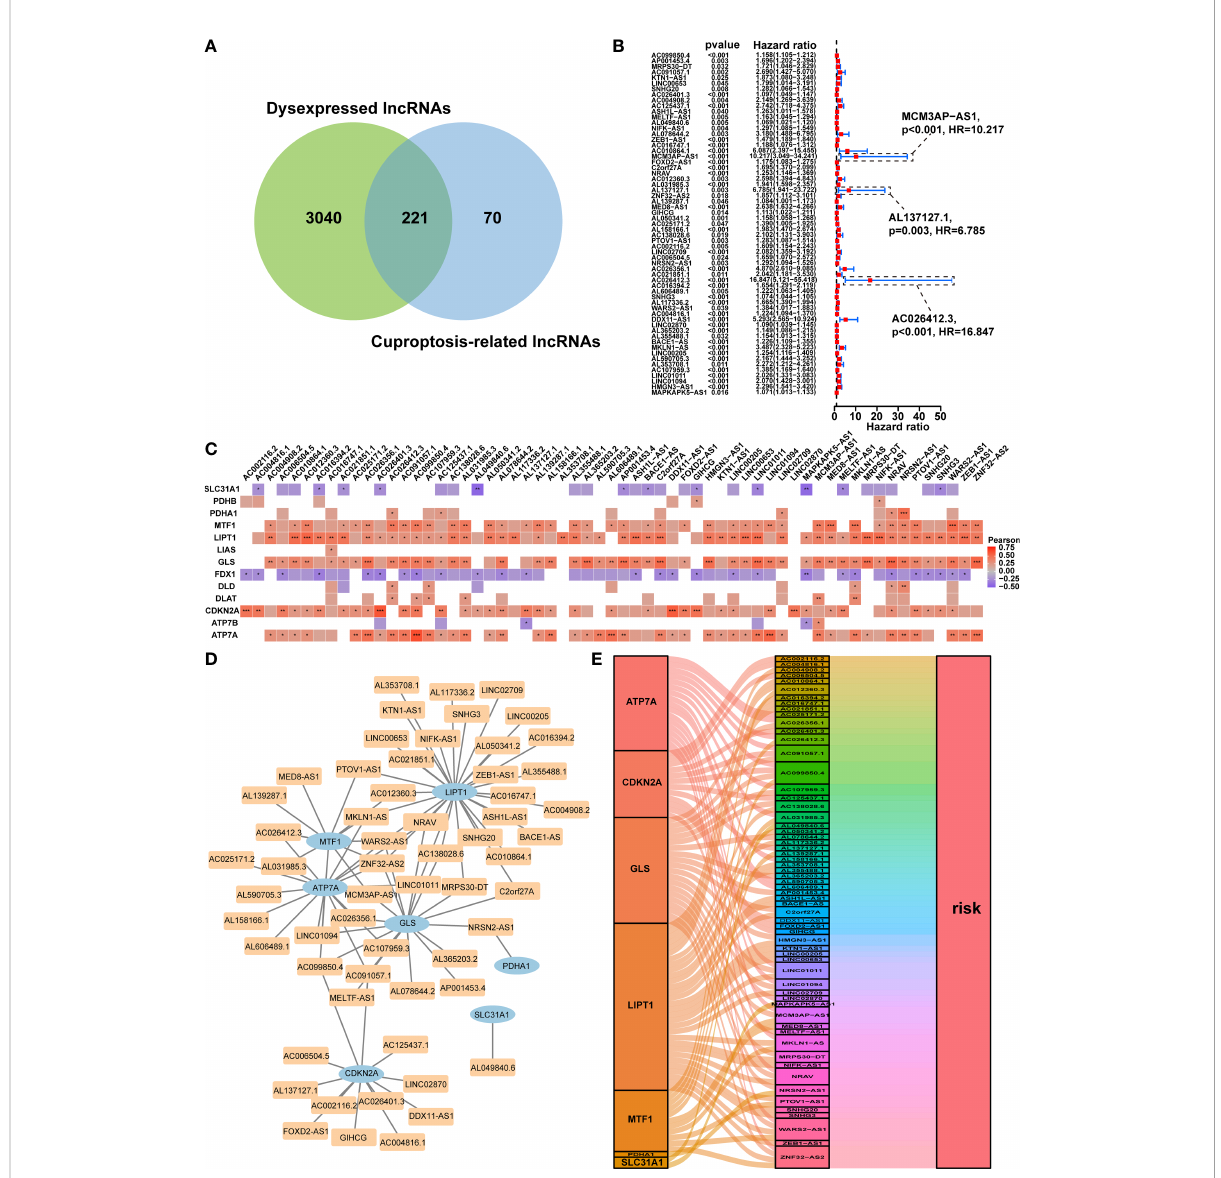
FIGURE 2 Prognostic analysis of differentially expressed cuproptosis-related lncRNAs and the construction of a coexpression network. (A) Venn diagram identifying the lncRNAs shared by differentially expressed lncRNAs and cuproptosis-related lncRNAs. (B) Forest plots displaying the outcomes of the univariate cox regression analysis of about 61 prognostic differentially expressed CRLs. (C) The correlation between 61 prognostic CRLs and 13 CRGs in the TCGA-HCC cohort. Each unit ’ s color indicated the degree of correlation. Red implied the positive relationship, blue was on the contrary. (D) Coexpression network of 61 prognostic differentially expressed CRLs and CRGs based on the Pearson ’ s R>0.4 and P<0.001. (E) The Sankey diagram illustrated the link between the 61 prognostic differentially expressed CRLs and CRGs on the basis of Pearson ’ s R>0.4 and P<0.001. lncRNAs, long noncoding RNAs; CRLs, cuproptosis-associated lncRNAs; CRGs, cuproptosis-related genes; HCC, hepatocellular carcinoma. *p < 0.05, **p < 0.01, and ***p <